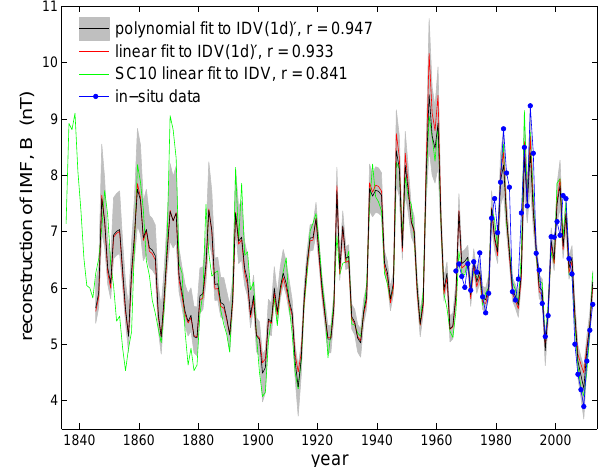
Fig. 7. Reconstructions of the near-Earth IMF, B , from geomagnetic data. The black line uses the new geomagnetic activity composite, IDV(1d) and the polynomial fit to B . The grey area surrounding this black line is the uncertainty band associated with using this polynomial fit derived using a Monte Carlo technique (see text for details). The red line shows the best reconstruction using a linear fit. The green line shows the SC10 reconstruction. Blue dots show the annual means of the observed IMF.